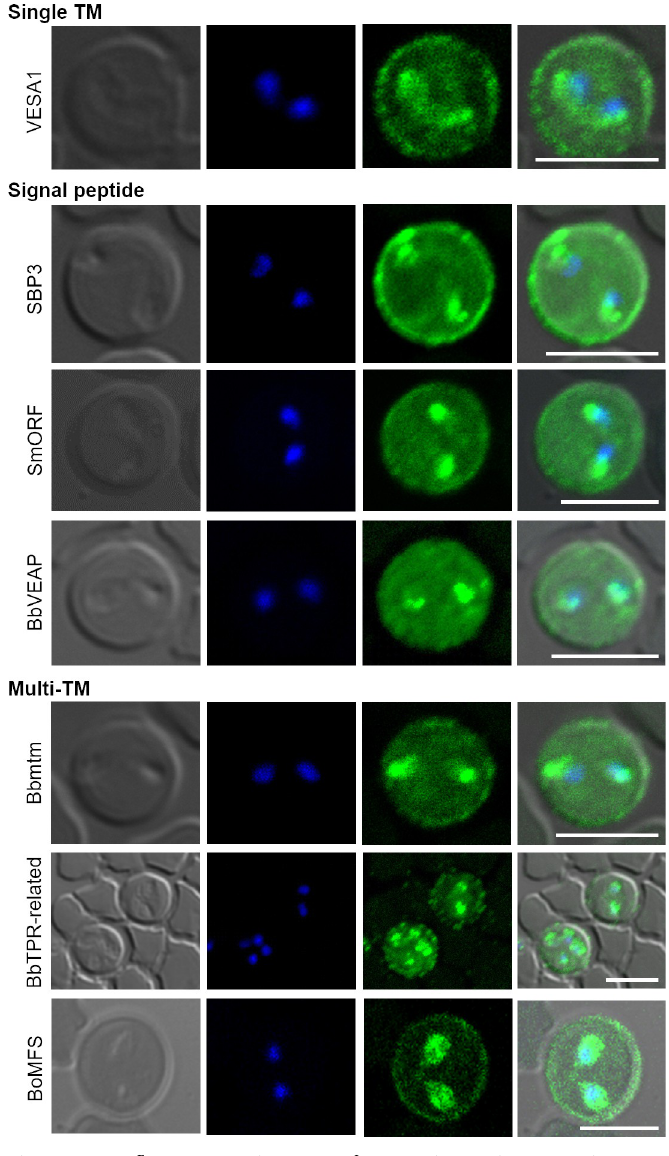
Fig 2. Immunofluorescence microscopy of transgenic parasites expressing myc-tagged exported protein. Myc- tagged proteins were episomally expressed in B . bovis (VESA1, SBP3, SmORF, BbVEAP, Bbmtm, and BbTPR-related) or B . ovata (BoMFS). The expression plasmid was constructed and transfected by electroporation as described [32,33], and transgenic parasites were selected using WR99210. Thin smears of cultured parasites were prepared for indirect immunofluorescence microscopy, fixed with a 1:1 acetone:methanol mixture, and reacted with anti-myc mouse monoclonal antibody (9B11, Cell Signaling) followed by Alexa Fluor 488-conjugated goat anti-mouse IgG (Invitrogen, green). Nuclei were stained with Hoechst 33342 (Hoechst, blue). Scale bar = 5 μ m. BbVEAP, B . bovis VESA1-export associated protein; IgG, immunoglobulin G; SBP3, spherical body protein 3; SmORF, Small Open Reading Frame; VESA1, variant erythrocyte surface antigen